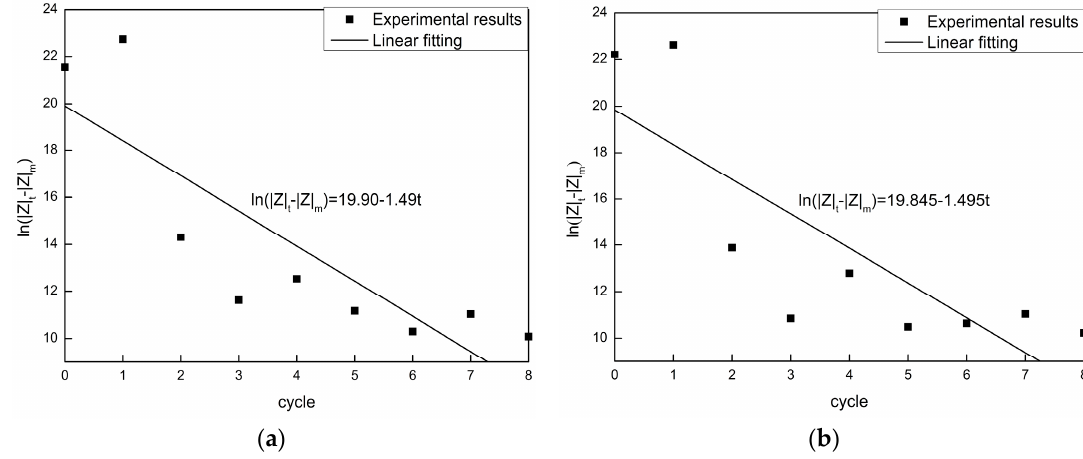
Figure 6. The fitting results of the two specimens using degradation kinetic model: ( a ) Plate 1#; ( b ) Plate 2#.